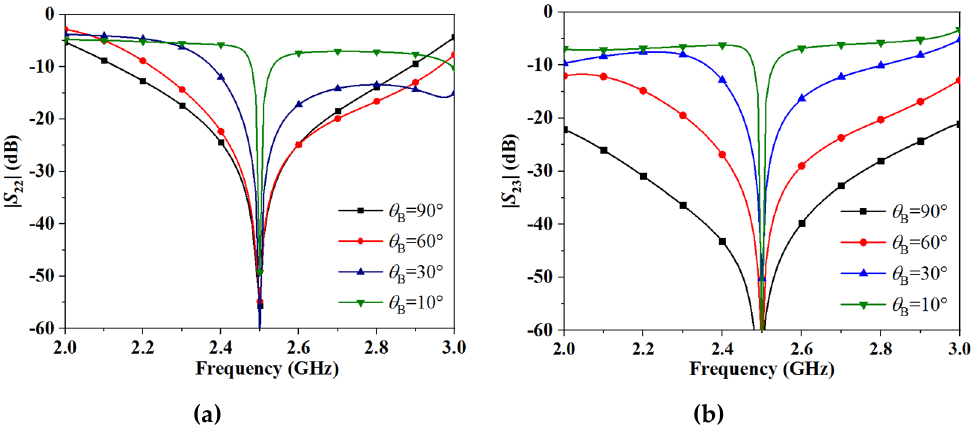
Figure 5. The effect of θ B on the performance of IsC. ( a ) |S 22 |; ( b ) |S 23 |. The value of θ B for the proposed balun is 0°, so the IsC cannot be directly connected to the proposed balun. Without affecting the performance of the proposed balun, two identical transmission lines are connected between the output ports of the balun and the IsC, as shown in Figure 6. The characteristic impedance and the electrical length of the transmission line are represented by Z 0 and θ R . When the output phase delay is increased by θ R , the S-parameters matrice